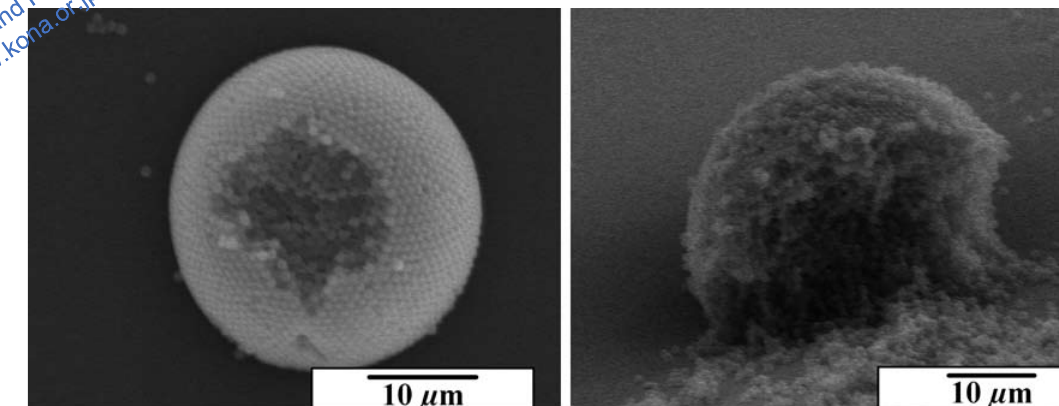
Fig. 6 SEM micrographs showing the inside of spherical particle assemblies formed from methanol emulsions in